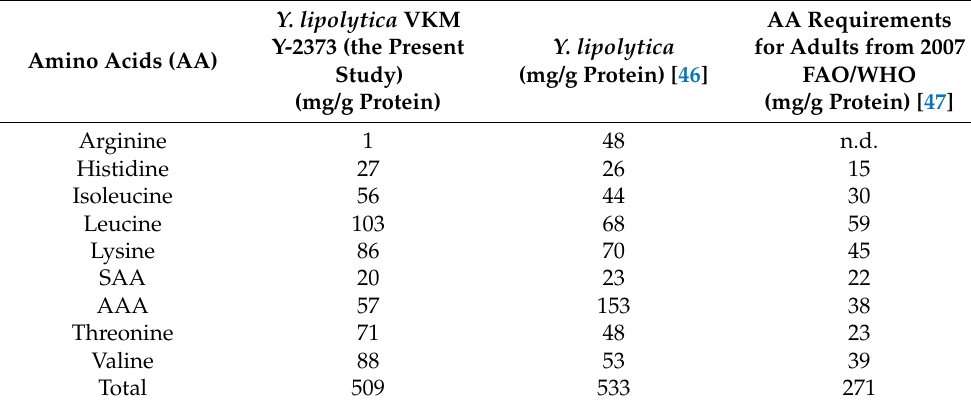
Table 6. Comparison of essential amino acids profile of Y. lipolytica VKM Y-2373 with literature data and FAO standard. Y. lipolytica VKM for Adults from 2007 Y-2373 (the Present Amino Acids (AA) (mg/g Protein) [46] Study) (mg/g Protein) [47] (mg/g Protein) Arginine n.d. Histidine